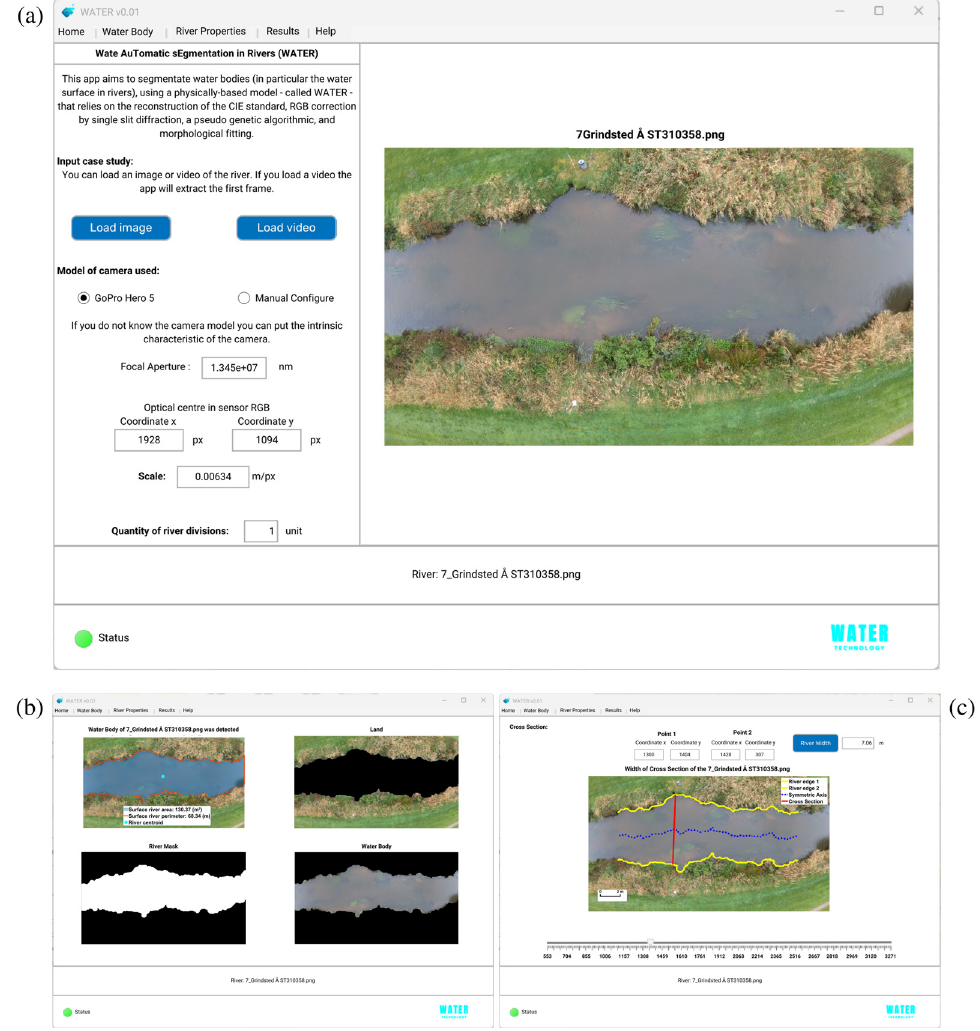
Figure 11. WATER software GUI with Grindsted case study (only for illustrative purposes, ID 6 in Supplementary Material E). ( a ) Home tab; ( b ) Results (river mask); ( c ) Results (symmetry axis and river width).